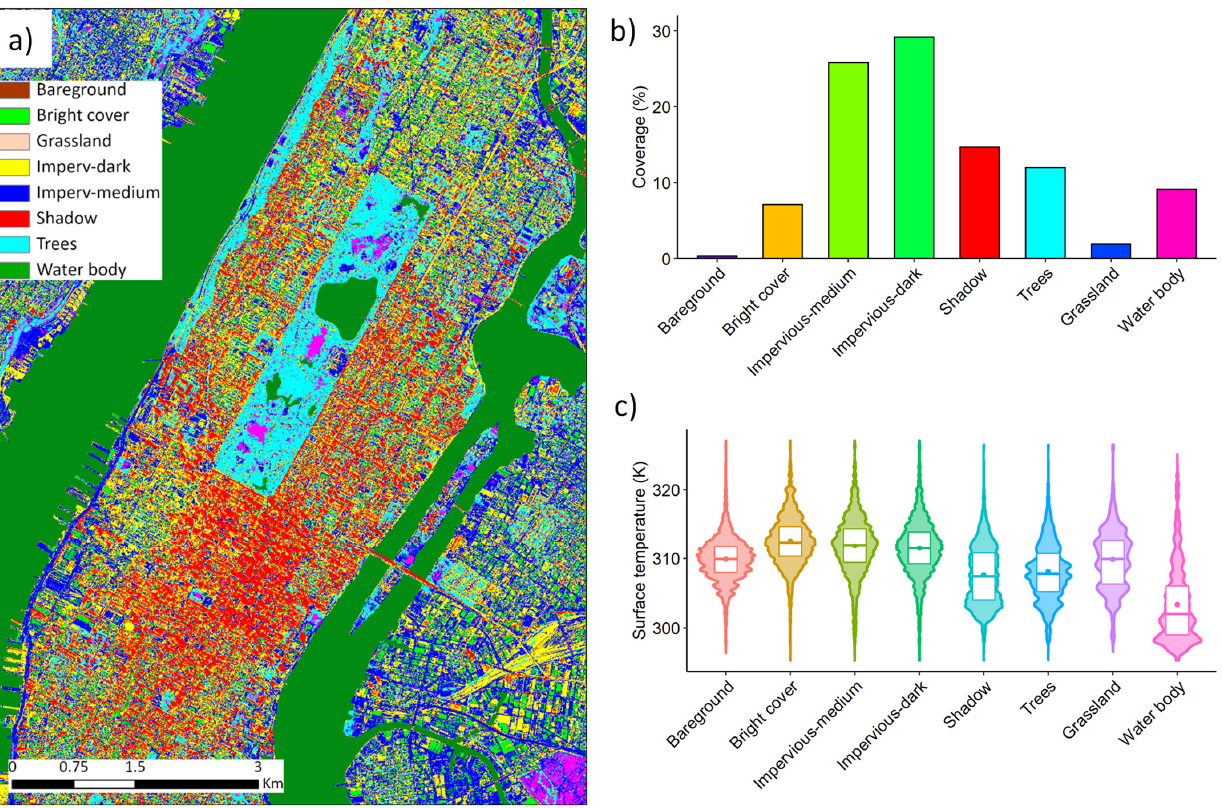
Figure 3. The figure shows: ( a ) The composition of urban materials obtained by classification of the QuickBird image using Fuzzy ARTMAP neural network scheme, ( b ) total coverage of urban components in Manhattan and its surrounding area, and ( c ) Violin chart with boxes represents the interquartile range (IQR) of surface temperature in different urban components. Mean (filled circle) and median (full line inside the box) is also shown.